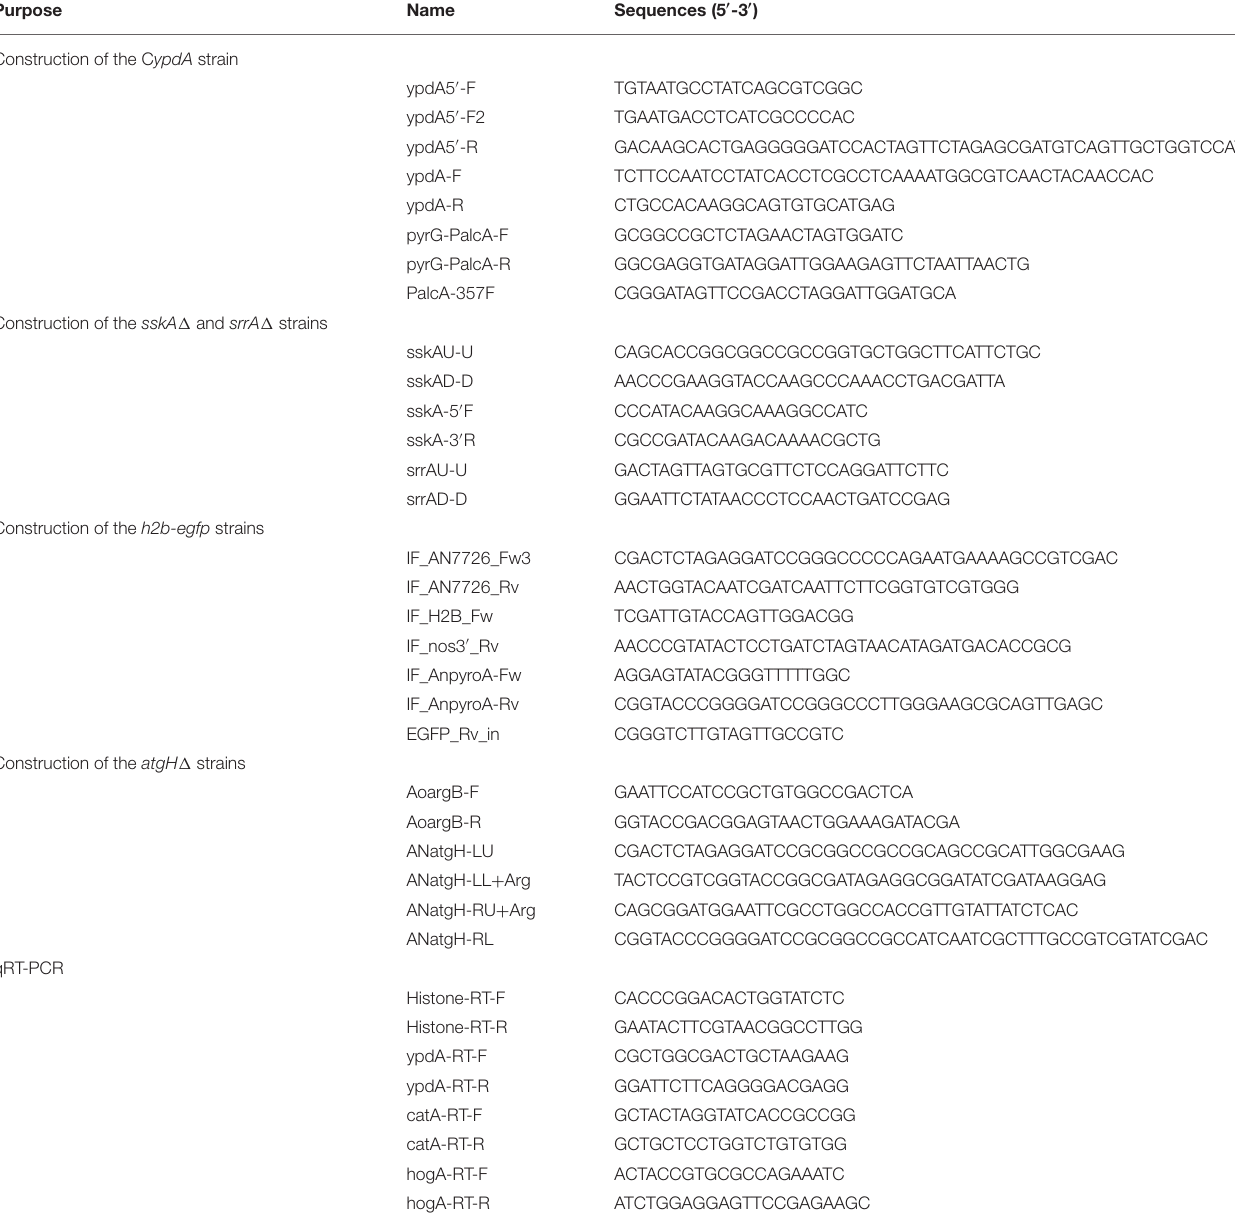
TABLE 2 | Primer sequences used in this